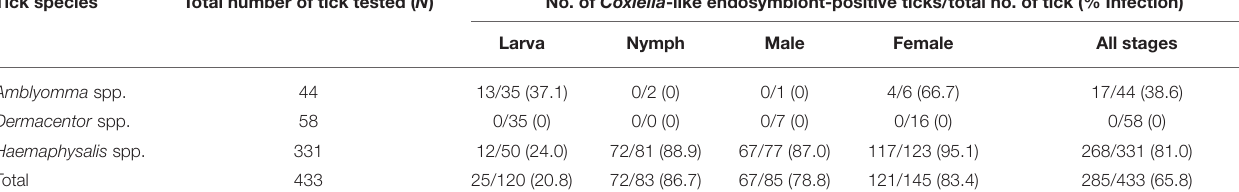
TABLE 4 | Prevalence of Coxiella -like endosymbiont in questing ticks, by tick genera and stages. Tick species Total number of tick tested ( N ) No. of Coxiella -like endosymbiont-positive ticks/total no. of tick (% Infection) Larva Nymph Male Female All stages Amblyomma spp. 44 Dermacentor spp.